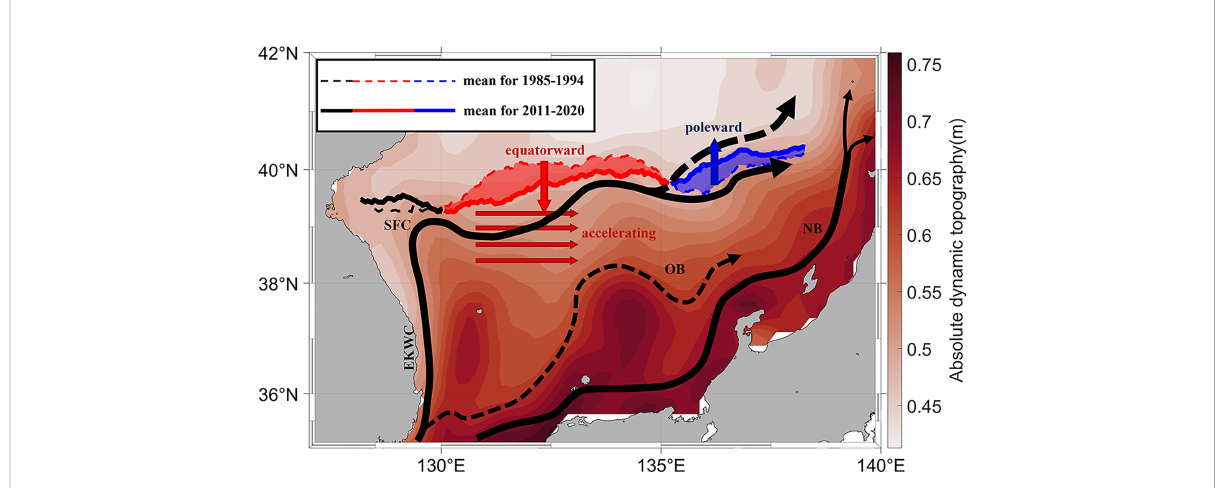
FIGURE 13 Schematic of the slantwise SPF in the JES. The average positions in the time periods 2011 – 2020 and 1985 – 1994 are denoted by the solid and dashed lines, respectively. The SPF is slanted more to the southwest-northeast as a result of the opposite meridional movements of the central and eastern SPF. The black, red and blue solid (dashed) lines are the western, central and eastern SPF, respectively. The shaded regions between the two lines are the meridional movements between the two decades. The black arrows denote the TWC. EKWC: East Korea Current, OB: offshore branch, NB: nearshore branch, TWC: Tsushima Warm Current, SFC: Subpolar Front Current. Red shading is climatological absolute dynamics topography (unit: